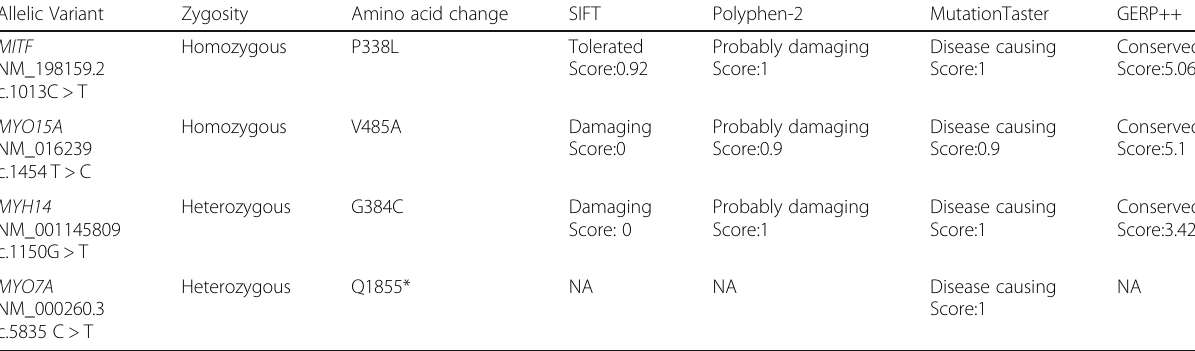
Table 1 Pathogenicity scores of detected variants assessed by SIFT, PolyPhen2, Mutation Taster, and GERP++ software Allelic Variant